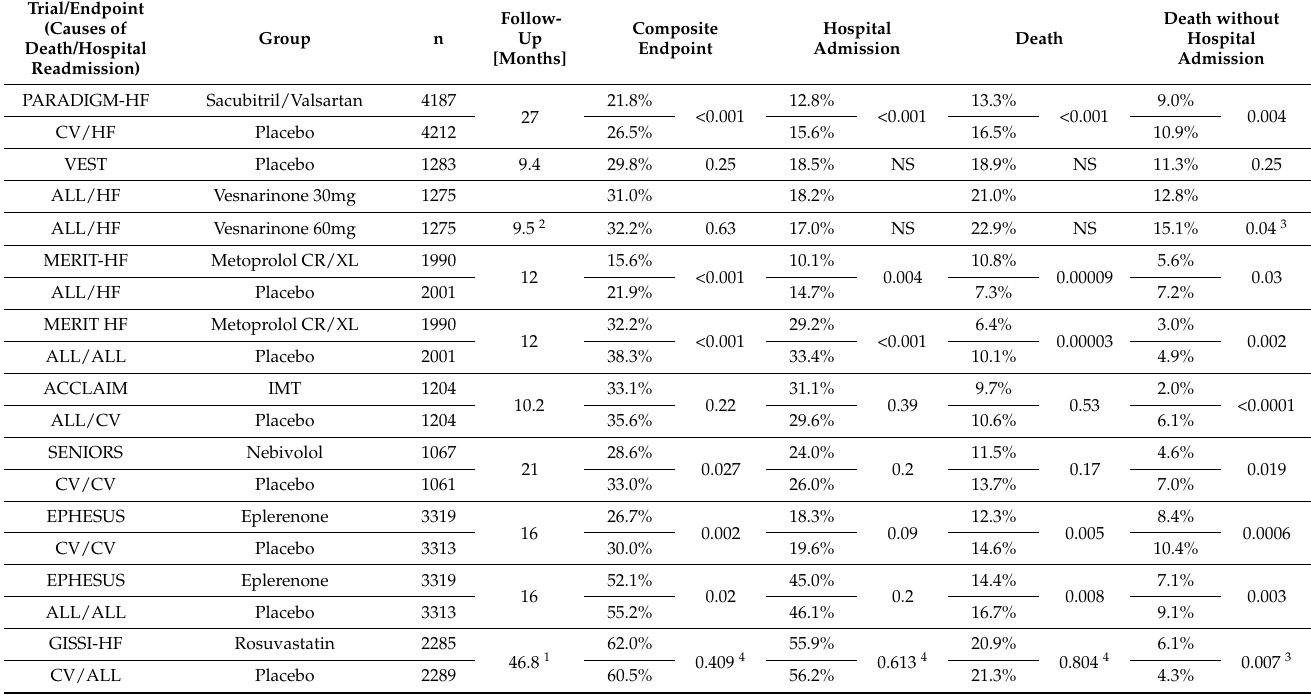
Table 3. Trials with a significant difference between groups regarding death without